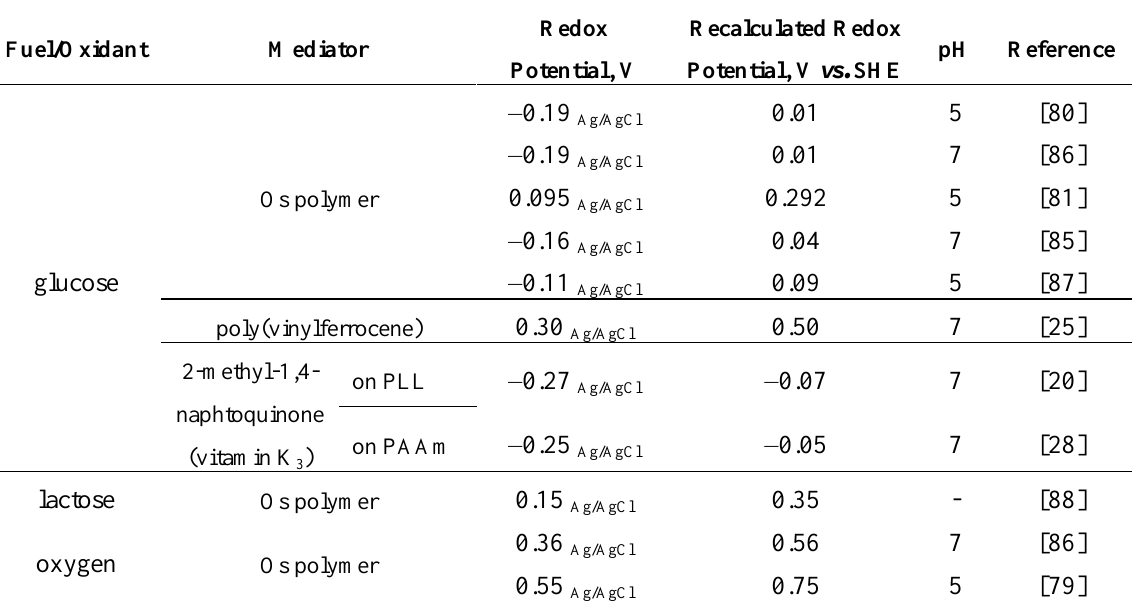
Table 6. Mediators immobilized on a polymer